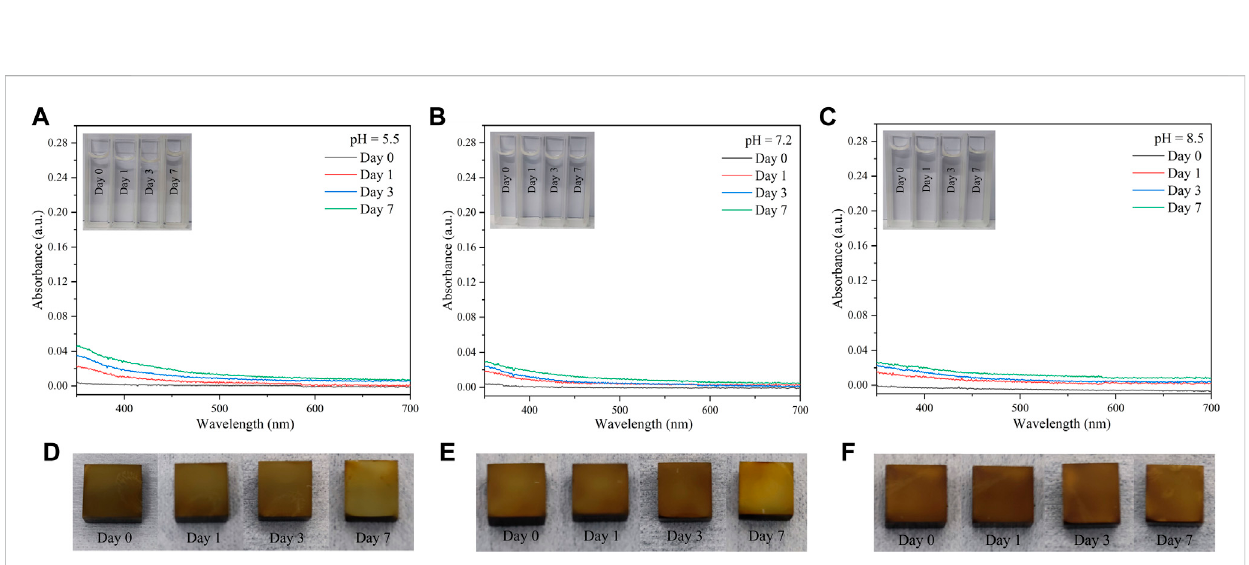
FIGURE 4 UV – visspectra ofdifferenteluents [ (A) pH=5.5, (B) pH=7.2,and (C) pH=8.5]ofTi-Cu@P(DA-co-SBMA) samplesafter differentdays. Photos